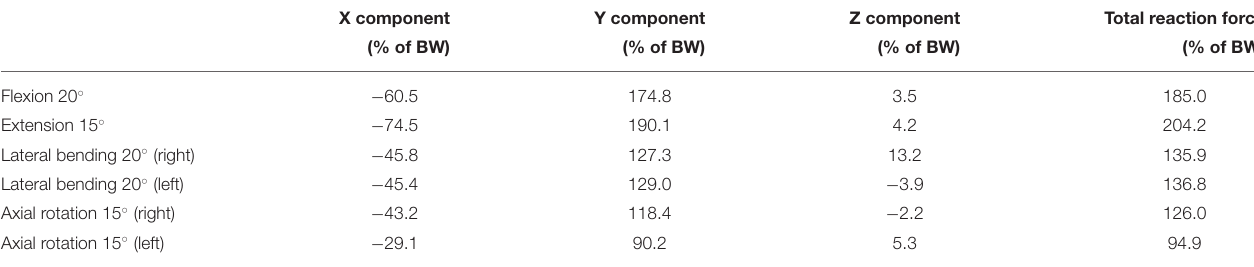
TABLE 1 | Reaction force at L4–L5 joint derived from the musculoskeletal model and used for the finite element analysis for six static positions of the spine.